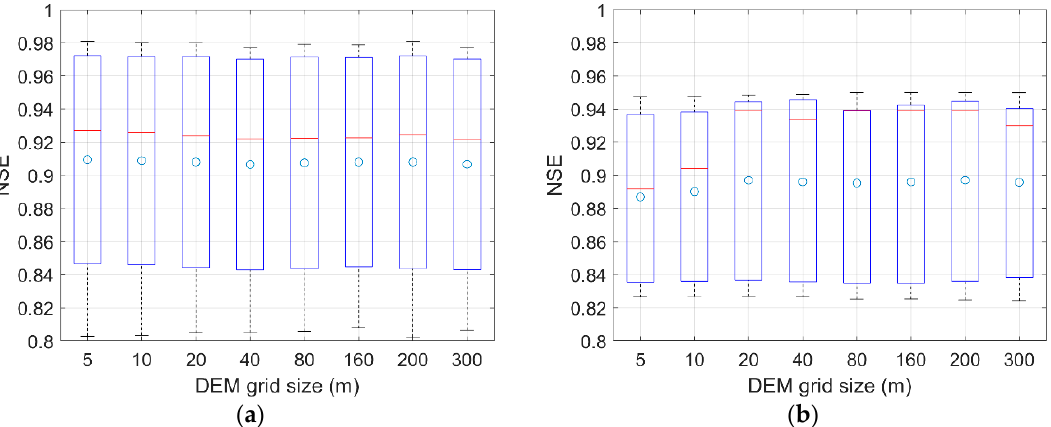
Figure 14. Results obtained using the optimized input parameters depending the DEM resolution for all Rainfall–runo ff events. ( a ) Dongkok watershed. ( b ) Ieemokjung watershed.